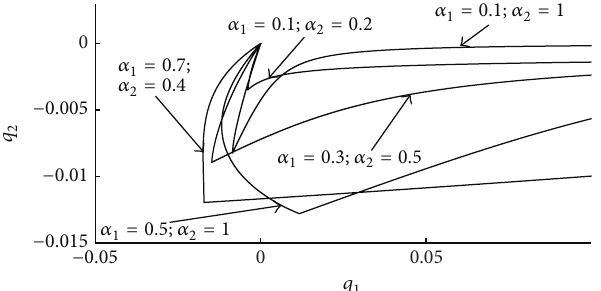
Figure 18: The phase trajectories in optimal control mode for Riemann-Liouville double